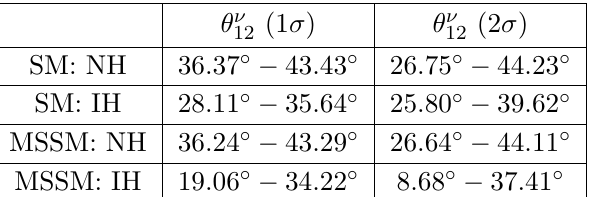
Table 2 . Viable 1 σ and 2 σ HPD intervals for θ ν δ PMNS . We have considered the RG evolution for the SM and the MSSM for both NH as well as for IH, as discussed in the main